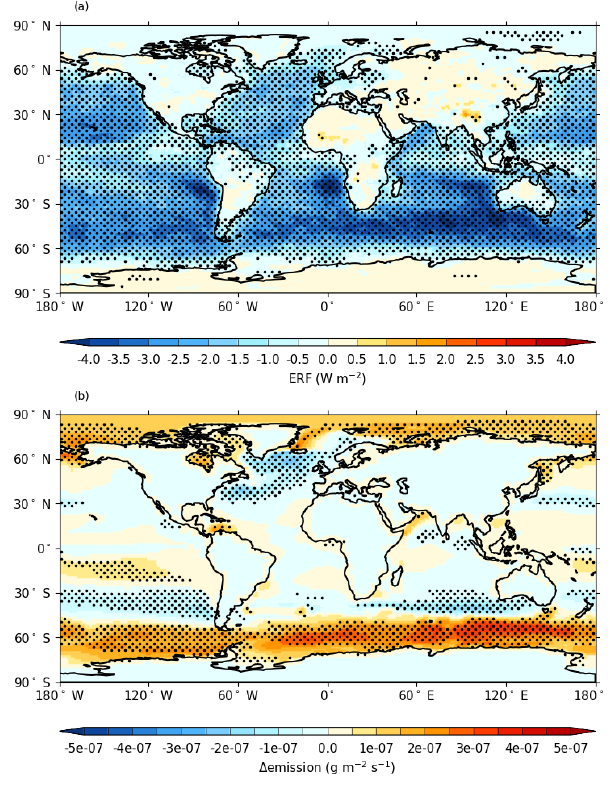
Figure 3. Multi-model mean (a) ERF from piClim-2xDMS vs. piClim-control , (b) change in DMS emissions (in g(S)) for abrupt- 4xCO2 vs. piControl . Stippling shows areas where the mean changes by more than the standard deviation across